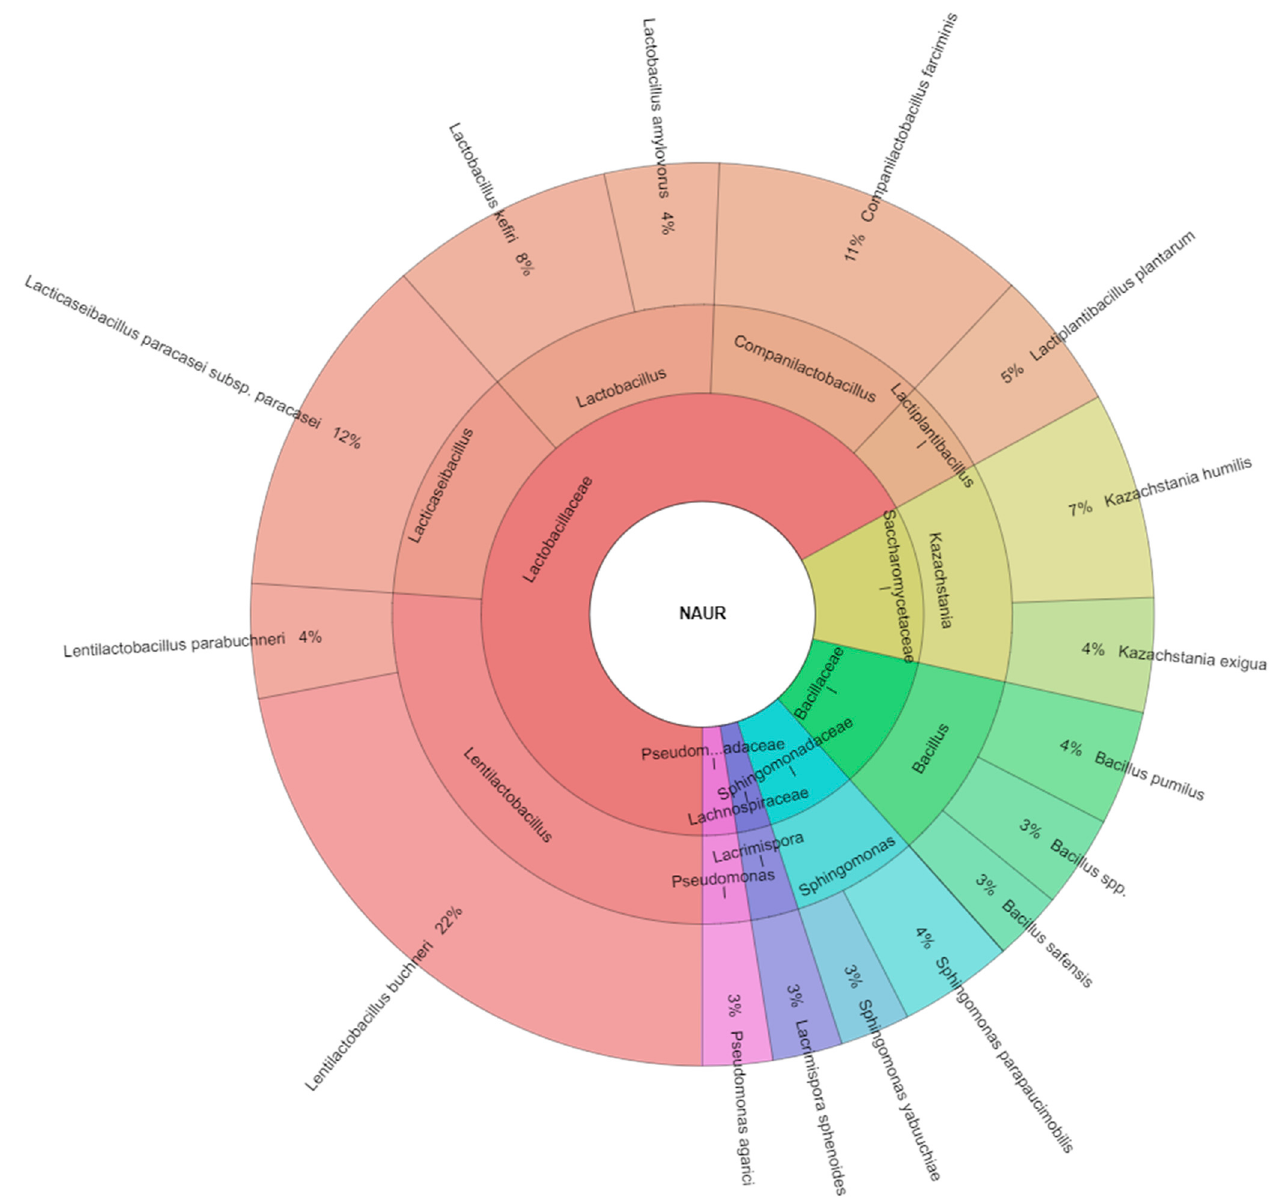
Figure 4. Krona chart of isolated species of bacteria and yeasts from samples of corn silage with nutritional additive: urea Table 5. The content of regulated mycotoxins in corn silage variants in μ g/kg.